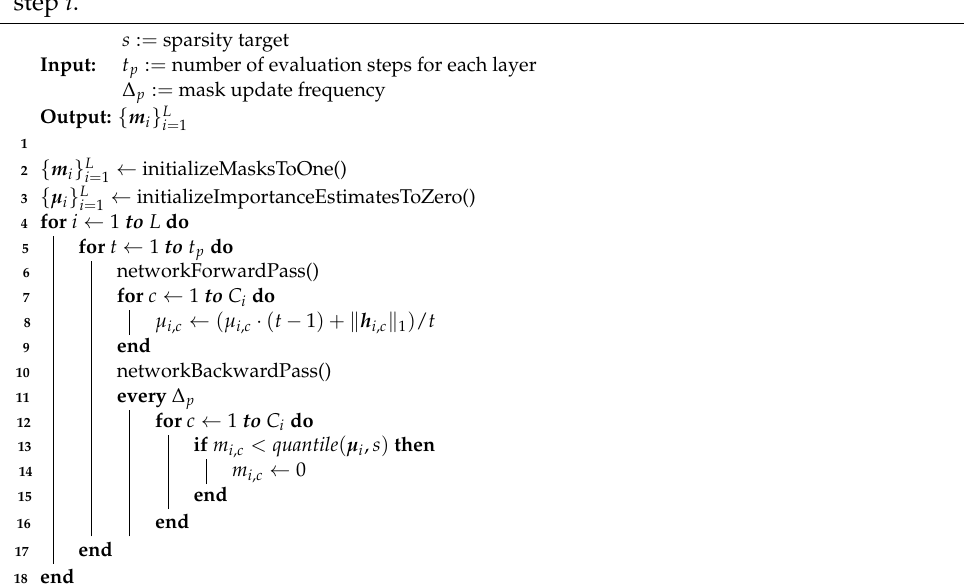
Algorithm 1: Our proposed layerwise channel pruning algorithm, using per- channel (cid:96) 1 -norm of activations to measure importance. All channel